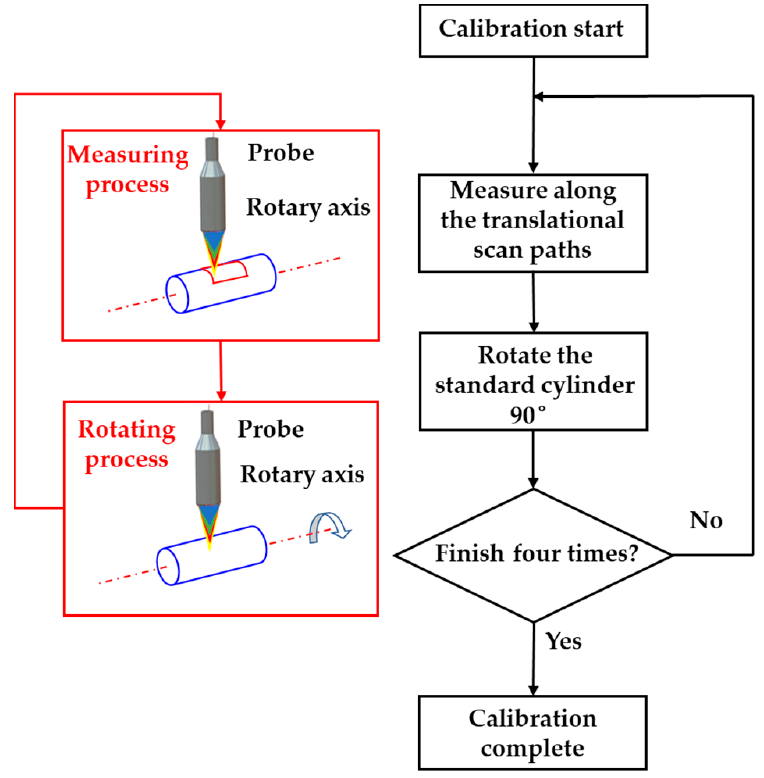
Figure 5. The calibration process of the static errors of a rotary stage. The rotary axes of the cylinder at these four positions could be calculated by cylindrical fitting with the measurement results, named L 1 , L 2 , L 3 , and L 4 , and the other three axes were generated by the rotation of the first axis L 1 . Four axes were symmetrically distributed around the rotary axis of the rotary stage, so that the real vector of it could be calculated by optimization. The coordinates of the two points on the rotary axis were the optimization objects. The first axis L 1 will be rotated 90 ◦ , 180 ◦ , and 270 ◦ around the optimized rotary axis and the form L , L , L , L , L , and L did not coincide with L 2 , L 3 , and L 4 , and the 2 (cid:48) 3 (cid:48) 4 (cid:48) 2 (cid:48) 3 (cid:48) 4 (cid:48) optimization was finished when the total distance between them reached the minimum. By taking the optimized vector as the rotary axis, the first point cloud at 0 ◦ was rotated 0 ◦ , 90 ◦ , 180 ◦ , and 270 ◦ around it and four virtual point clouds were generated. As shown in Figure 6, both the measured and virtual point clouds were compared in the same coordinate system, which were drawn in blue and red,